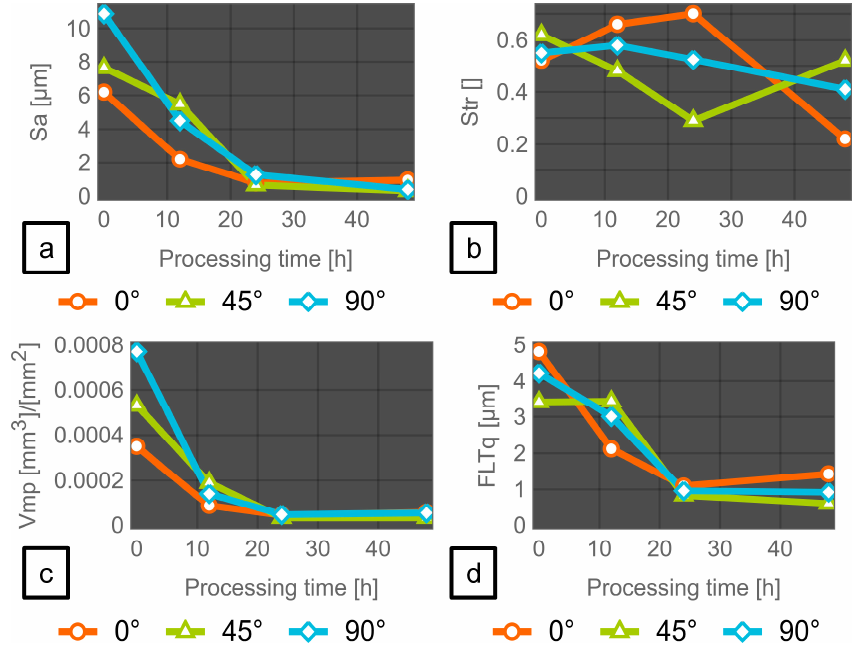
Figure 12. Trends of areal parameters for investigated building orientations: Sa ( a ), Str ( b ), Vmp ( c ), and FLTq ( d ).